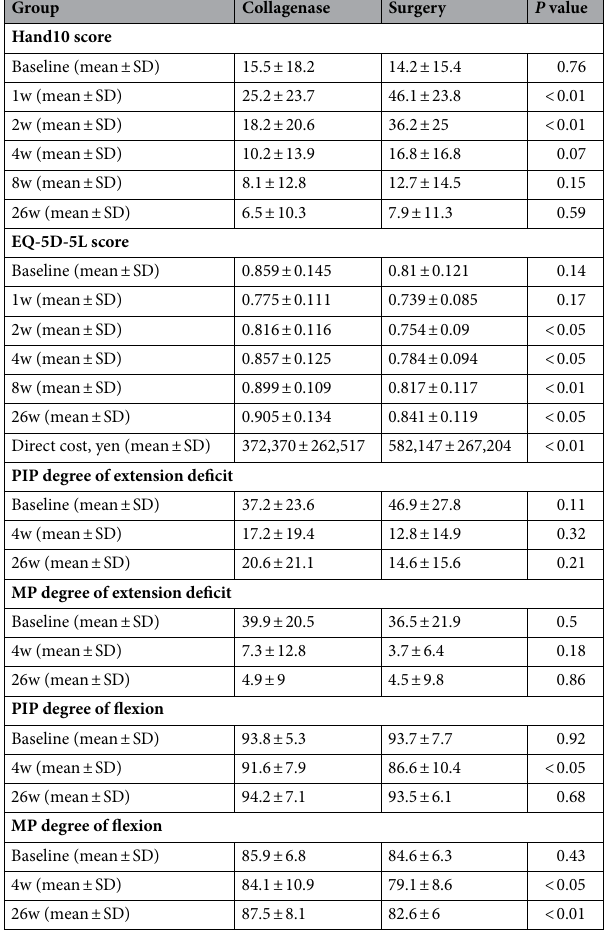
Table 5. Outcomes before propensity score adjustment. w week, MP metacarpophalangeal, PIP proximal interphalangeal, SD standard